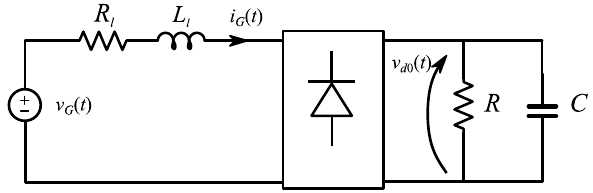
Figure 1. Circuit model of the considered case study. Table 1. Parameters of the equivalent circuit.